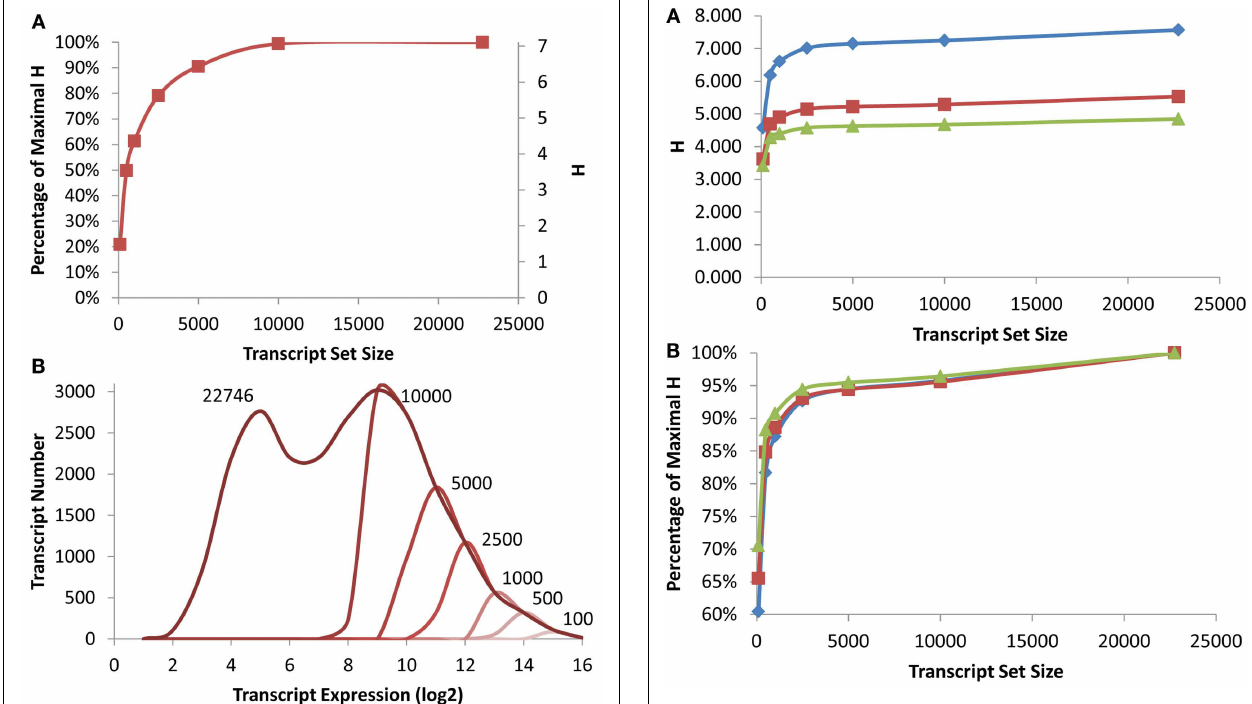
FIGURE 1 |Transcriptomic information in Arabidopsis . (A) Shown is the absolute and fractional Shannon Entropy of the Arabidopsis transcriptome when limiting the analysis to gene sets of the X most expressed transcripts ranging from the 100 top expressed genes to the entire dataset as shown on the X axis. (B) Shown is the frequency distribution of the average transcript expression level in the microarrays used for this analysis.The darkest line shows the distribution for all transcripts with decreasing red indicating the smaller transcript subsets down to 100 being the lightest red as labeled.